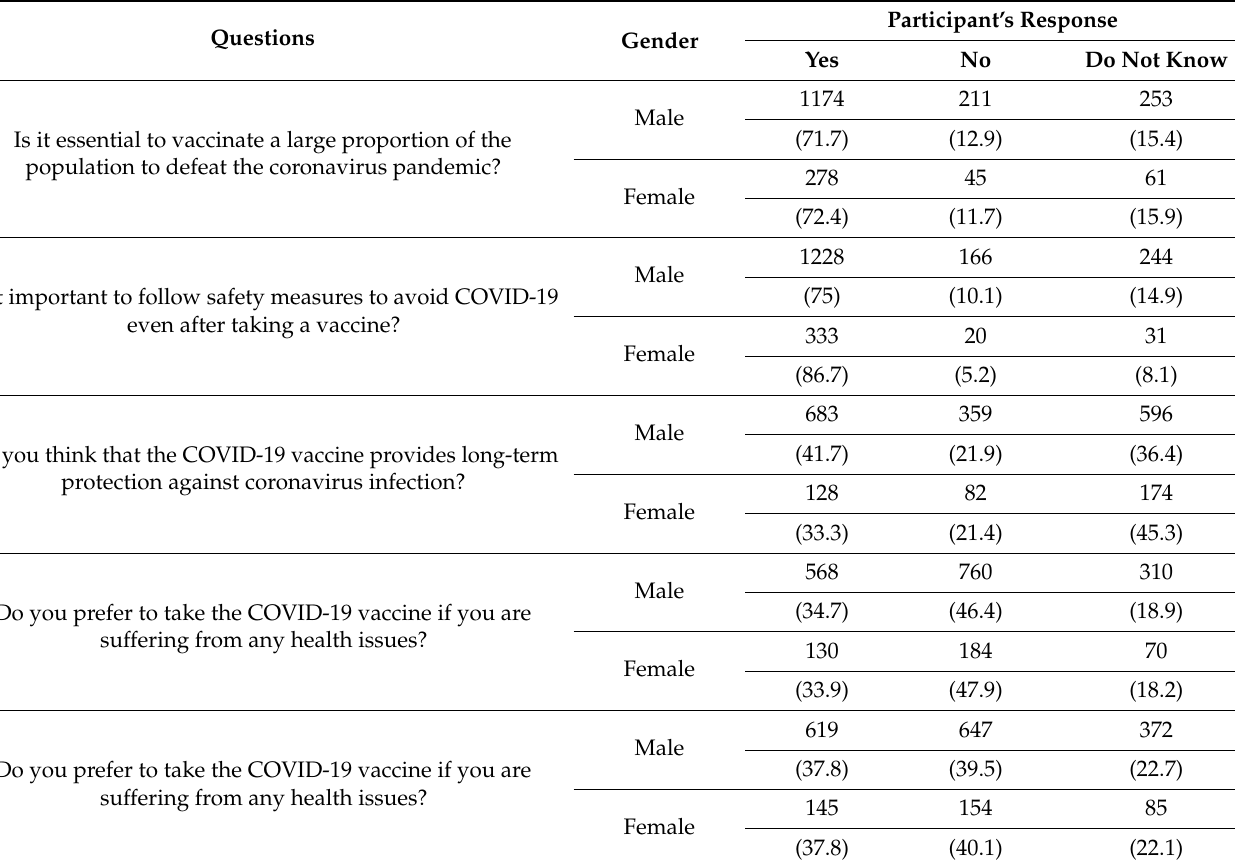
Table 4. Frequency of response for the perception questions by Saudi